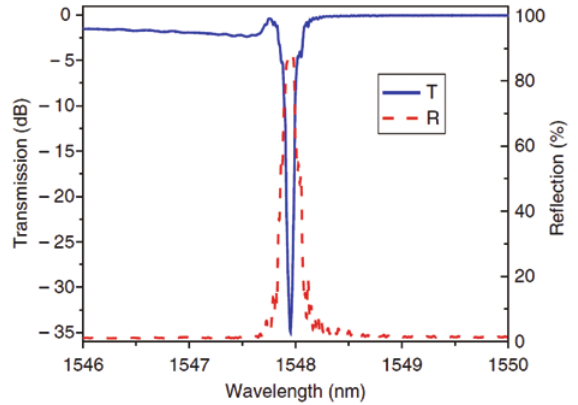
Figure 4: Transmission (T) and reflection (R) spectra of a WBG written in fused silica using the modulated burst method. Reprinted with permission from [26].